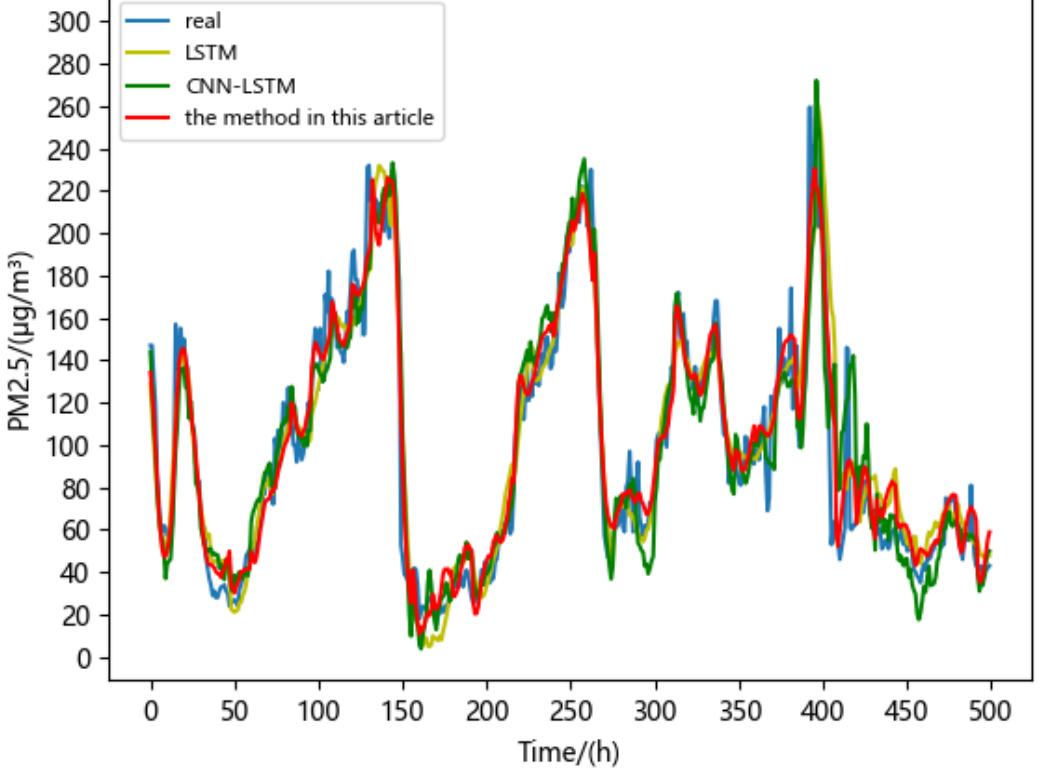
Figure 8. The prediction results of the three methods with a prediction step of 12 h.